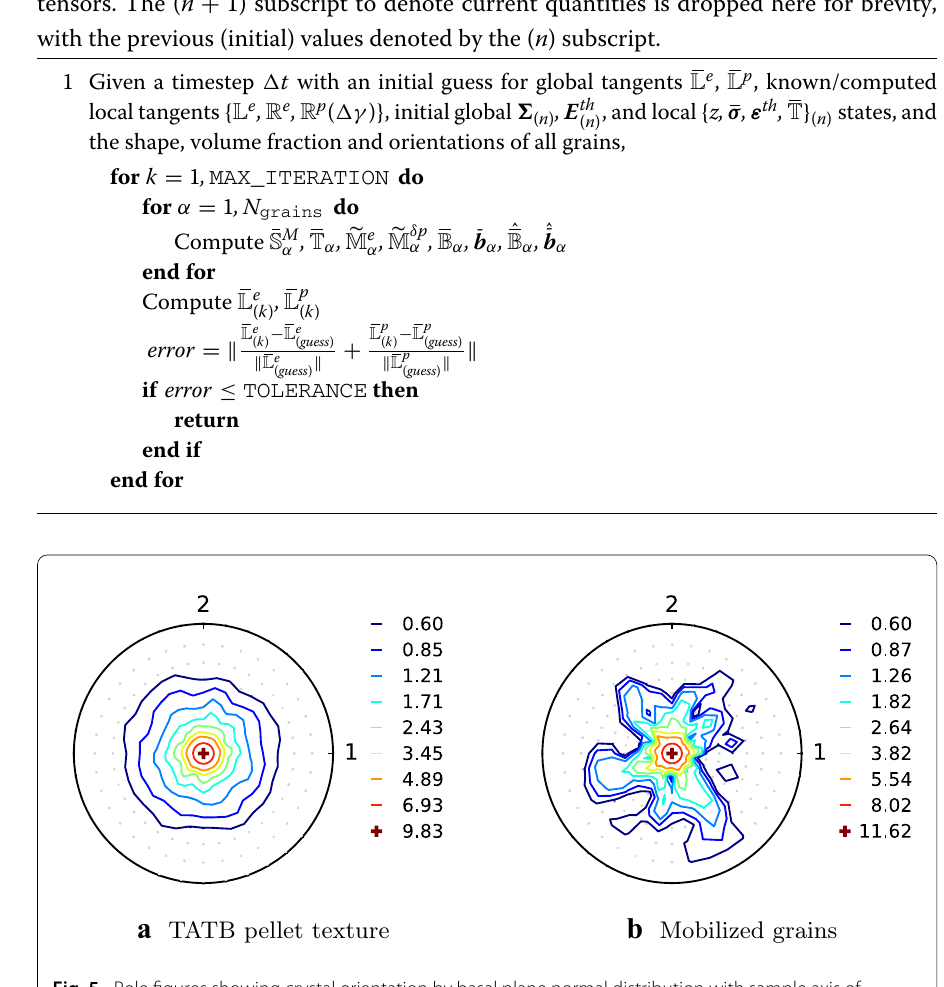
Fig. 5 Pole figures showing crystal orientation by basal plane normal distribution with sample axis of transverse isotropy aligned with the center of pole figure: a TATB neat-pressed pellet texture after measurements of Yeager et al. [67], and b mobilized grain orientations at onset of plasticity where approximately 1/4 of the grains (252 of them) are slipping. Units are “times random”